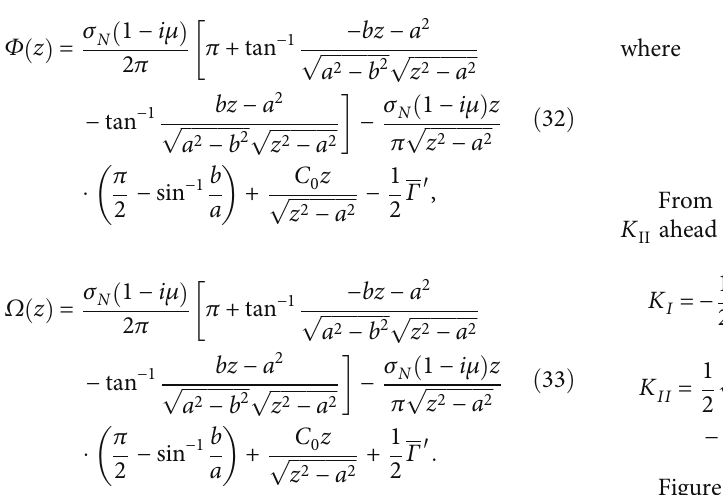
Figure 8: The relationship curve between the parameters W and b